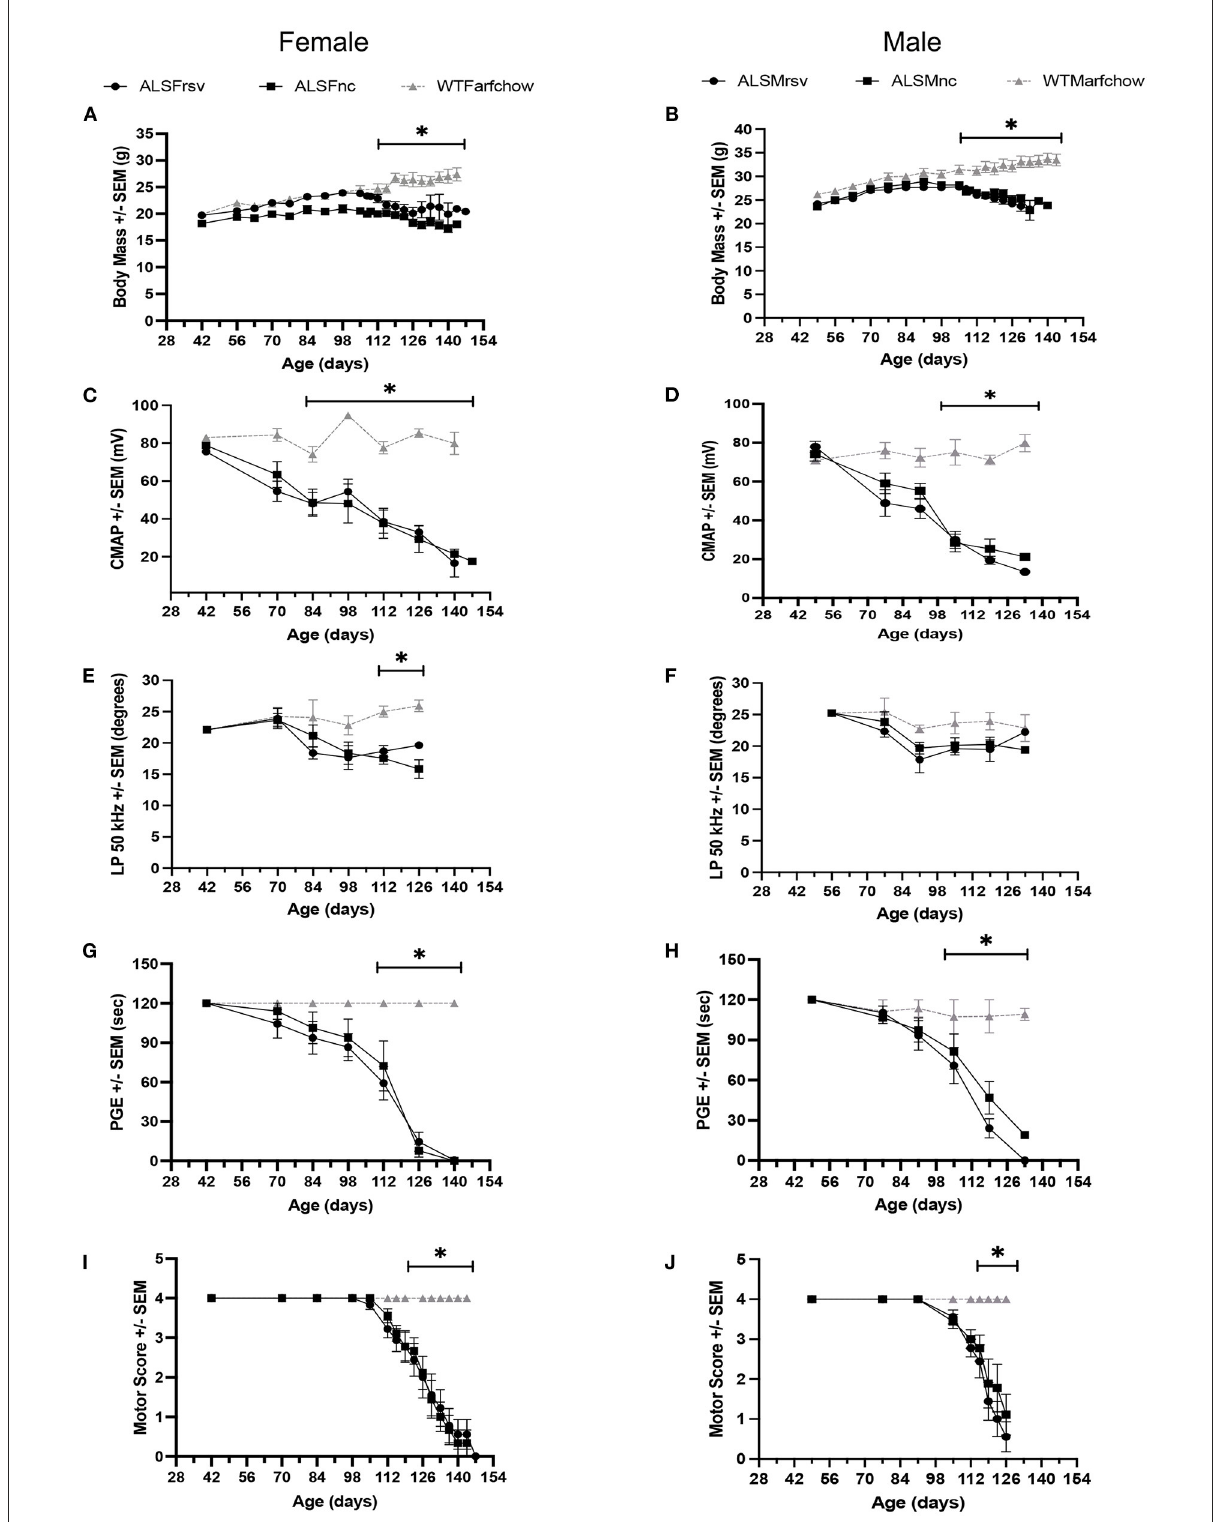
FIGURE3 Bi-weekly measures for RSV-treated vs. untreated female and male ALS mice vs. WT animals. (A, B) Body mass. (C, D) CMAP amplitude. (E, F) LP 50kHz. (G, H) PGE. (I, J) Motor score. ALSF, ALS female; ALSM ALS male; WTF, wild type female; WTM, wild type male. RSV, Resveratrol-treated animals; NC, Untreated animal received normal chow. Significant difference from WT values for that measure are indicated by